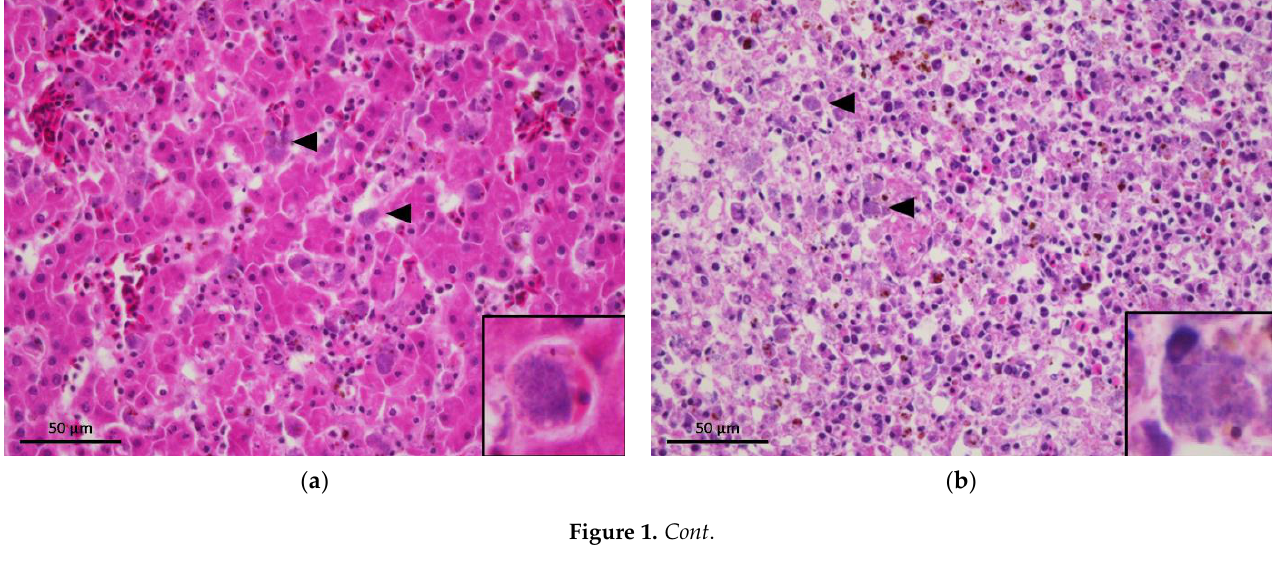
( f ) Figure 1. The result of histopathological examination and immunohistochemical (IHC) staining. ( a ) In the liver, there are various numbers of intracytoplasmic basophilic punctate organisms in the hepatocytes and macrophages (arrowheads); H&E stain, ×400. ( b ) Intracytoplasmic basophilic punctate organisms distributed in splenic macrophages (arrowheads); H&E stain, ×400. ( c ) Large botryoid inclusion bodies (indicated by the arrowheads) within the cytoplasm of macrophages in the bursa of Fabricius with lymphoid depletion; H&E stain, ×400. ( d ) and ( e ) Strong Chlamydia -positive signals detected